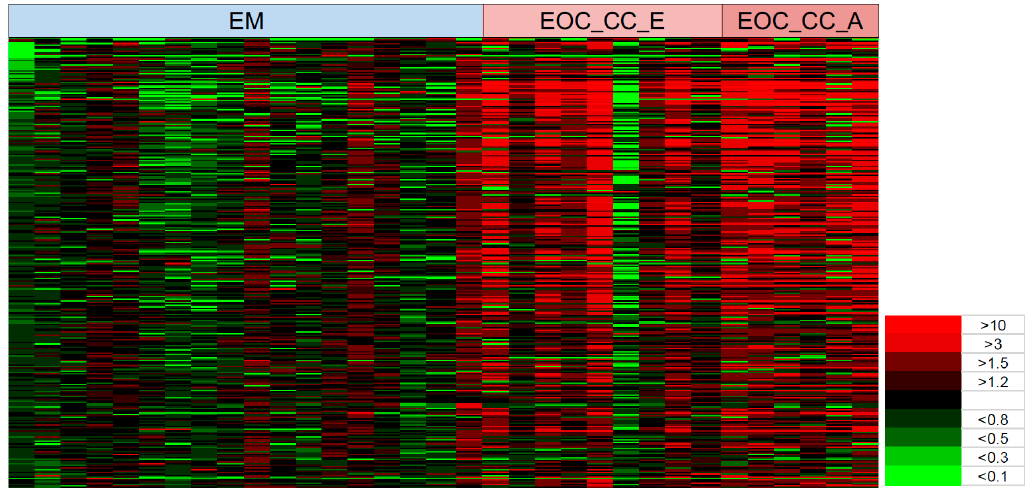
Figure 6. Heat map of glycopeptides in the blood sera of early OCCC, advanced OCCC and endometrioma patients. The Y -axis represents 300 individual glycopeptides in the MS spectra and the X -axis represents the individual patients in endometrioma, early OCCC, and advanced-stage OCCC patient groups. The spectral colors in the matrix represent the ratio level of glycopeptide peaks in the individual compared to the average level in the non-cancer group ranging from the brightest green ( < 0.1) to the brightest red ( > 10). Abbreviation: OCCC, ovarian clear cell carcinoma; EM, endometrioma; EOC_CC_E, early-stage OCCC; and EOC_CC_A, advanced-stage OCCC.